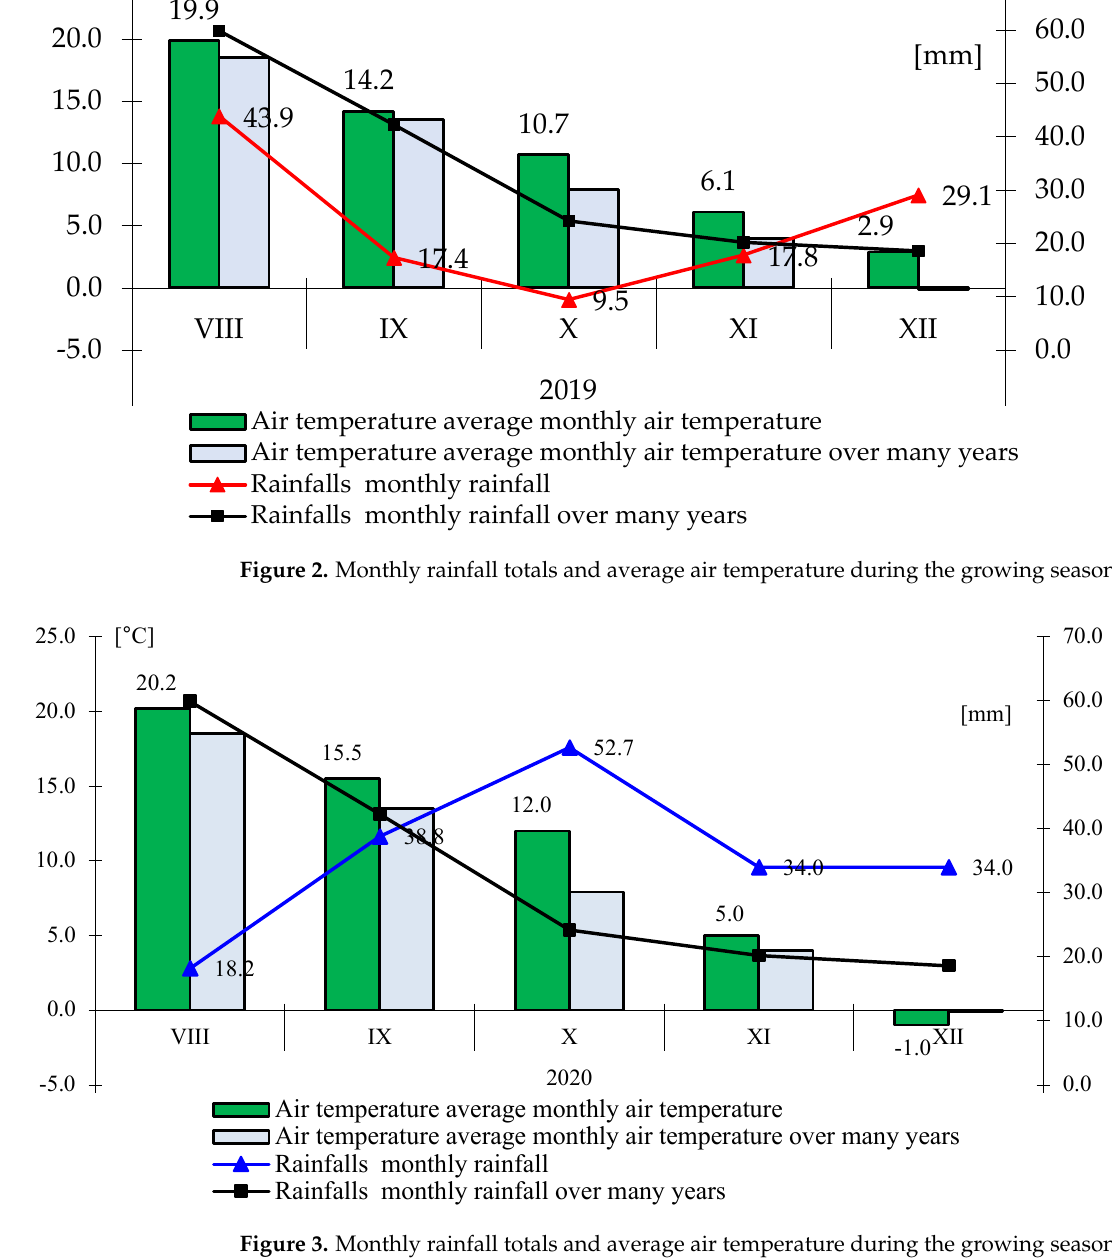
Figure 3. Monthly rainfall totals and average air temperature during the growing season 2020.